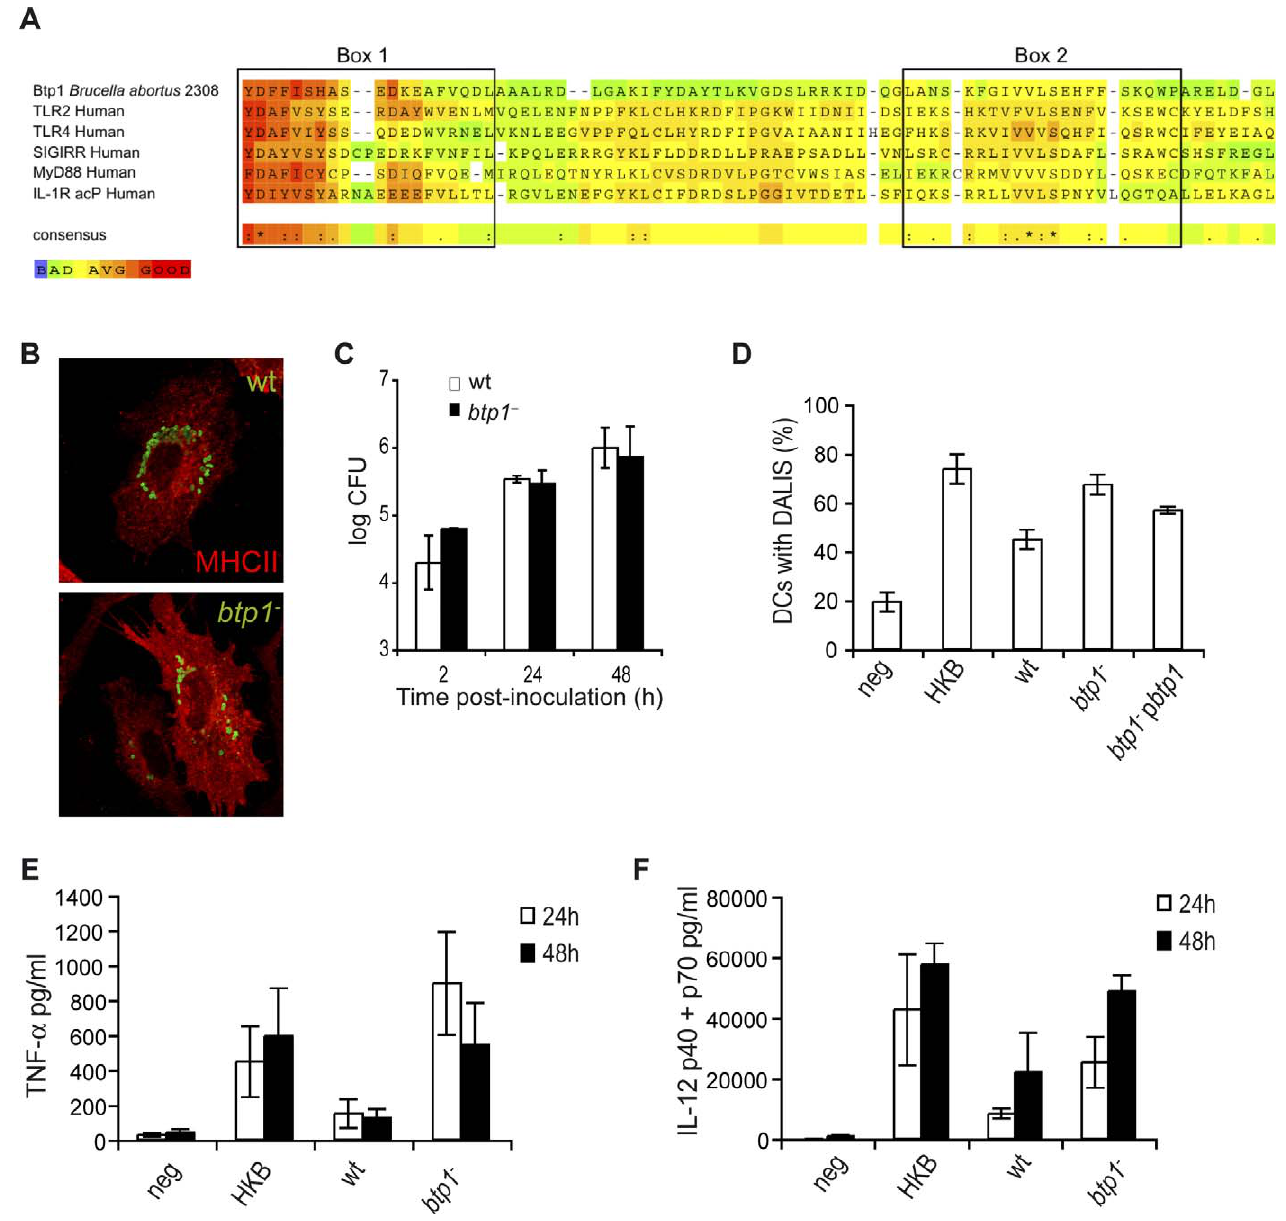
Figure 6. Btp1 Reduces DC Maturation (A) Identification of Btp1 as bacterial member of TLR/IL-1R (TIR) family. Comparison of the predicted amino acid sequences of Btp1 with the human members of the TIR family: TLR2, TLR4, Single Immunoglobulin IL1-R related molecule (SIGIRR), Myeloid Differentiation protein 88 (MyD88), and IL-1 Receptor accessory protein (IL-1R acP). Significant sequence similarity is observed in Box 1 and Box 2, which are important signatures of all TIR domain proteins. The alignment was constructed with T-Coffee::advanced server from EMBnet (http://www.ch.embnet.org/). The color scheme is represented in the figure and is indicative of the reliability of the alignment, with red corresponding to highest probability of correct alignment. DCs infected with wild- type B. abortus or btp1 (cid:2) were either (B) fixed at 24 h and immunolabelled for MHC II (red) and Brucella (green) or (C) cells were lysed at 2, 24, and 48 h and CFU enumerated. (D) Quantification of the percentage of DCs containing DALIS. DCs were incubated for 24 h with media (negative), heat-killed B. abortus (HKB), wild-type B. abortus (wt), btp1 (cid:2) mutant strain or a btp1 (cid:2) mutant with a plasmid containing btp1 ( btp1 (cid:2) p btp1 ). There is a very significant statistical difference between the wt and btp1 (cid:2) ( p ¼ 0.0002) but only a small difference between btp1 (cid:2) and btp1 (cid:2) p btp1 ( p ¼ 0.05). (E and F) Analysis of TNF- a and IL-12 (p40/p70) secretion measured by ELISA from the supernatant of DCs 24 and 48 h after inoculation. All the results correspond to the means 6 standard errors of four independent experiments. A statistical difference was observed between wild-type Brucella and btp1 mutant at 24 h for TNF ( p ¼ 0.029) and IL12 ( p ¼